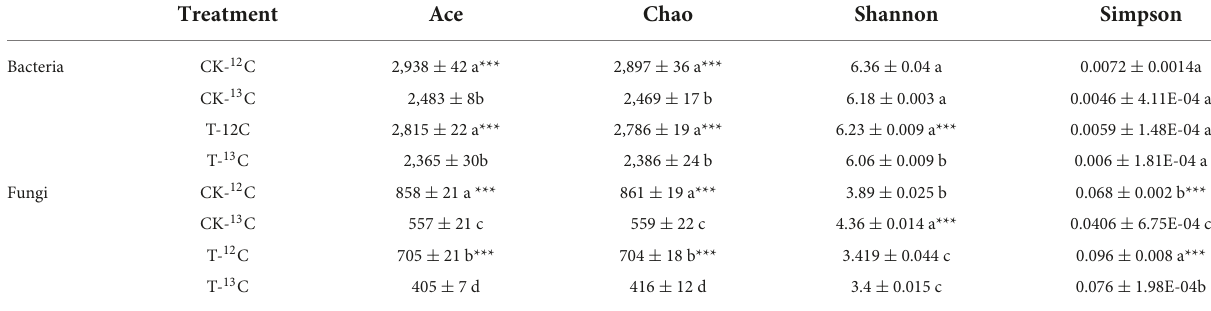
TABLE 1 Alpha diversity indices of bacterial and fungal communities in soil samples of 12 C- and 13 C-labeled DNA under CK and 4-HBA treatments (T). Treatment Ace Chao Shannon Simpson